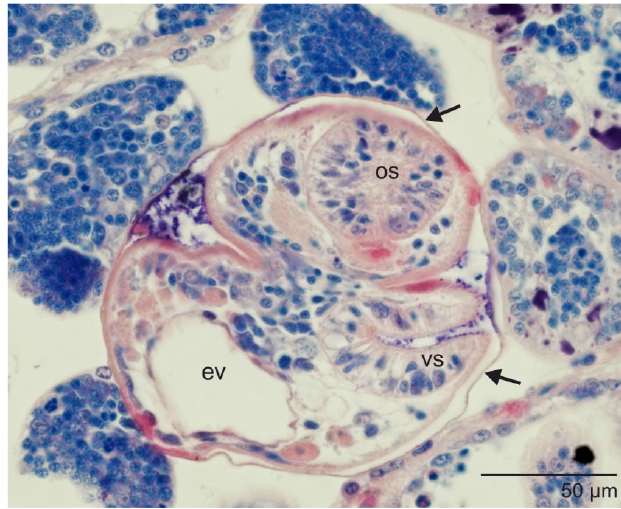
Figure 5. Histological section through infected whelk Neptunea despecta showing encysted metacercariae of Pseudozoogonoides subaequiporus within daughter sporocyst, Azur II-eosin staining. Abbreviations: ev—excretory vesicle; os—oral sucker; vs—ventral sucker. Arrows indicate cyst wall.